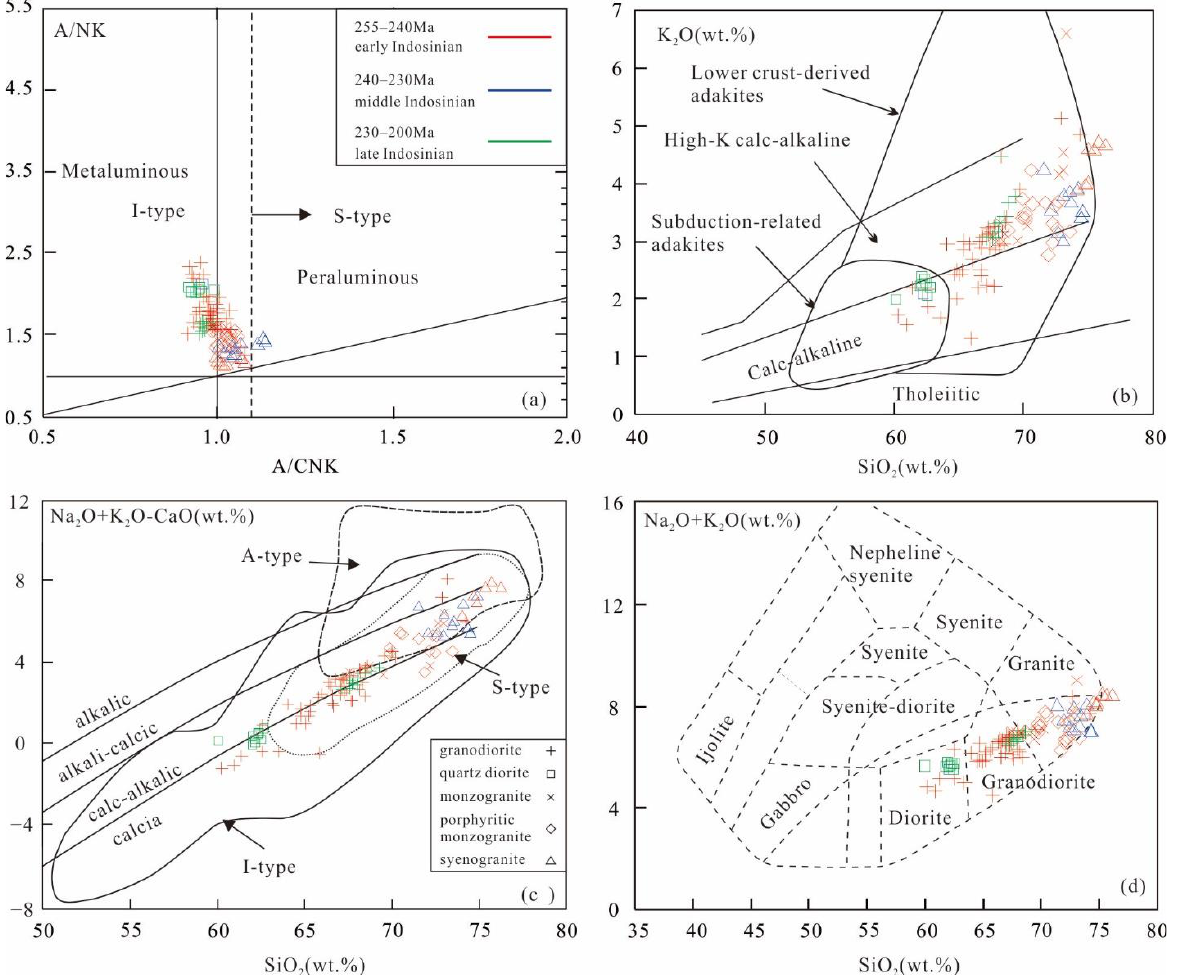
Figure 3. Diagrams of A/NK vs. A/CNK. A/CNK = Al 2 O 3 /(CaO + Na 2 O + K 2 O)% in molar; A/NK = Al 2 O 3 /(Na 2 O + K 2 O)% in molar. ( a ) (after [39]) K 2 O vs. SiO 2 ; ( b ) (after [40]) (Na 2 O + K 2 O - CaO) vs. SiO 2 ; ( c ) (after [41]) ALK vs. SiO 2 ; ( d ) (after [42]) for the Indosinian granite in the eastern region of the EKO.